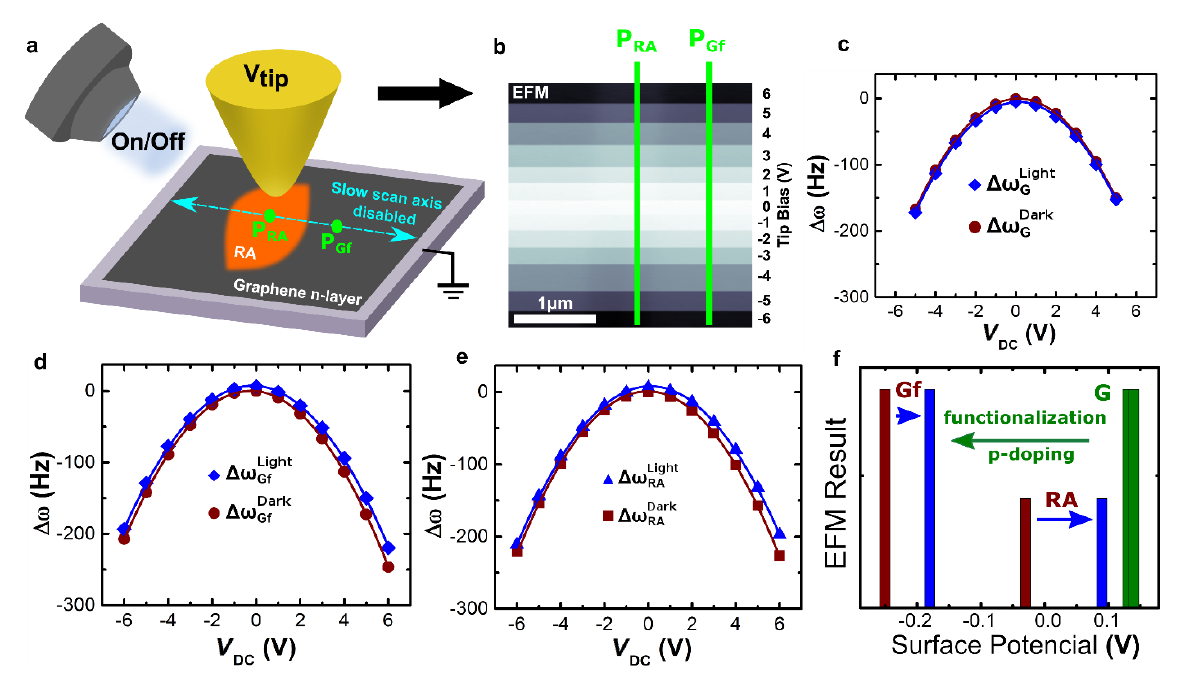
Figure 4: Photo-assisted EFM characterization of the RA/graphene hybrid. (a) Schematic drawing illustrating the photo-assisted EFM experiments. The measurements were performed either in dark (LED off) or under illumination (LED on) on the sample consisting of a graphite microplate sub- strate (gray) partially covered by RA monolayers (orange). The microscope slow scan axis was disabled and the probe scanned over the same line (blue dashed line) while the image was captured. The bias was applied to the tip ( V tip ) and the sample remained grounded during the experiment. The P RA and P Gf points refer to RA monolayer-covered and noncovered regions of the graphite microplate substrate, respectively. All the experiments were performed at ambient conditions. (b) Typical raw EFM image of the photo-assisted experiment. The P RA and P Gf lines refer to RA monolayer- covered and noncovered regions, respectively, where the bias V tip varies along the line. The photo-assisted EFM results are summarized in plots of the frequency shift ∆ω at different biases V tip for (c) pristine graphene ∆ω G (or graphite microplate – prior to any deposition), (d) functionalized graphene ∆ω Gf (P Gf line) and (e) RA monolayer ∆ω RA (P RA line) in dark (brown curves) and under illumination (blue curves). The brown- and blue- colored symbols in (c), (d) and (e) represent measurements made with and without LED illumination, respectively. The plot in (f) shows the surface potential variation of pristine (G) and functionalized (Gf) graphene/graphite and retinoic acid (RA) SAM upon